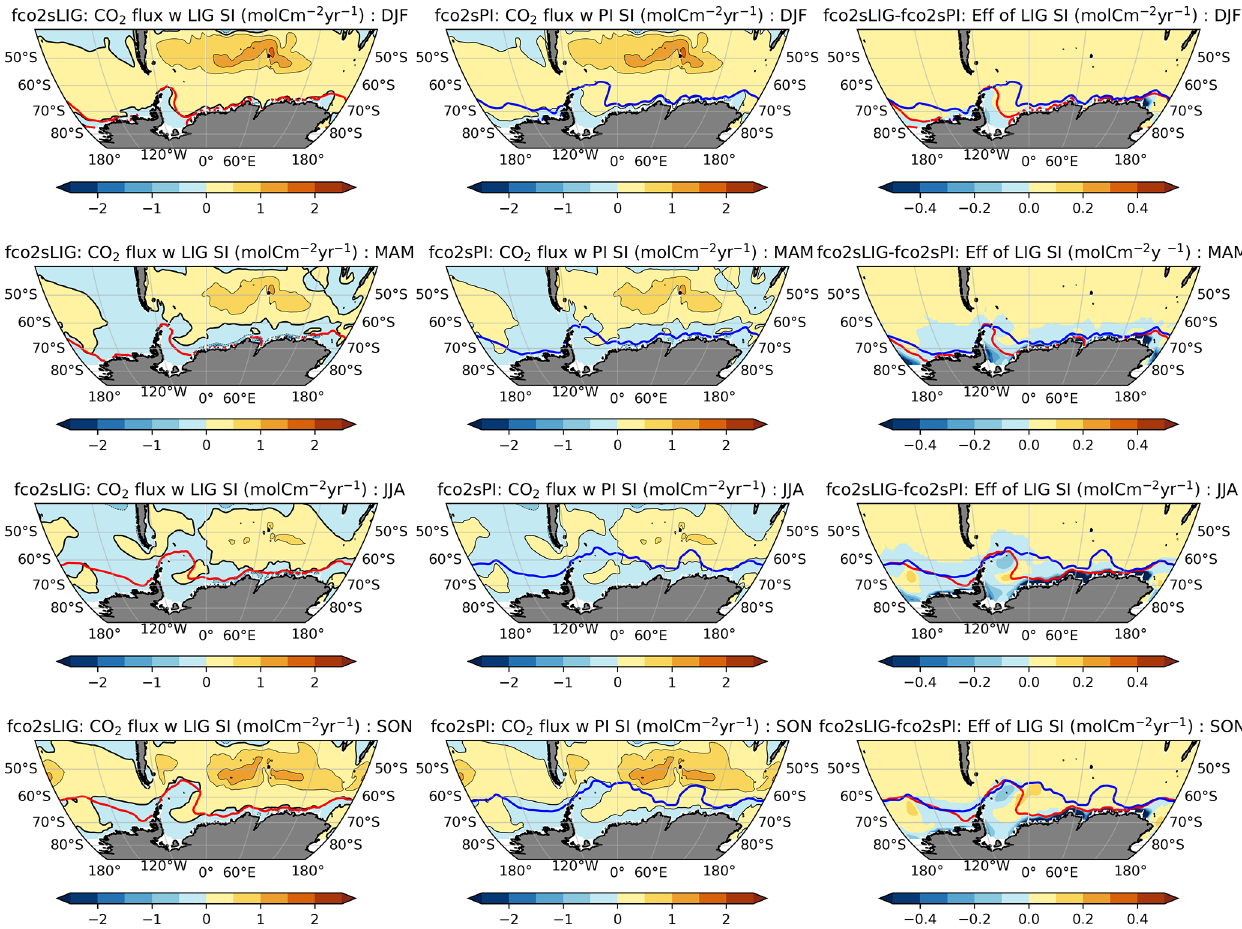
Figure A5. Calculated seasonal CO 2 fluxes using LIG (cid:49) pCO 2 , winds and (left) LIG sea-ice concentration, (middle) PI sea ice concentra- tions, and (right) differences in CO 2 flux for calculations using the LIG sea ice concentrations compared to PI sea ice concentrations. Note the reduced colour scale in the right-hand column. Calculations are based on Wanninkhof (1992) and Wanninkhof (2014). The red and blue contours indicate 15% sea ice concentrations for LIG and PI,